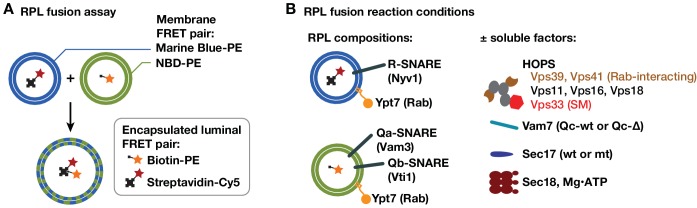
RPL fusion assay system.(A) The RPL fusion assay simultaneously monitors lipid and content mixing using orthogonal FRET pairs (Zucchi and Zick, 2011). Lipid mixing is monitored by FRET between phosphatidylethanolamine (PE) lipid derivitized with either NBD or Marine Blue. Content mixing is monitored through the association of encapsulated biotin and avidin conjugates (to phycoerythrin and Cy5 fluorophores, respectively). Although both lipid and content mixing signals were collected in the experiments shown, only content mixing signals are presented because the two signals were highly correlated, and because content mixing is the reaction's biologically relevant endpoint. (B) The RPLs used in this study contained a lipid mixture approximating that of the yeast vacuole membrane (Zick et al., 2014), native purified Ypt7-GTP, and either Qa and Qb, or R-SNAREs. The asymmetric SNARE topology allows docking and fusion without any prior requirement for Sec18-mediated cis-SNARE complex disassembly.